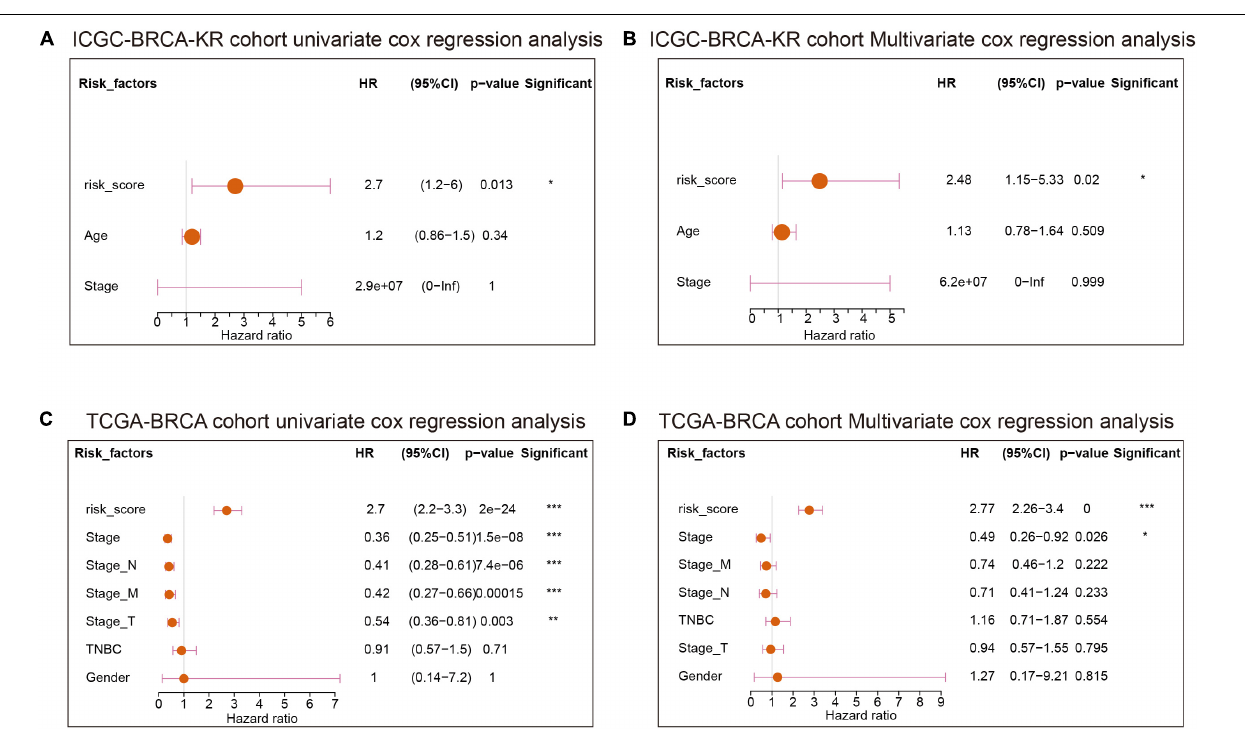
FIGURE 6 | The Cox regression of clinical characteristics and risk score of GVRM. (A,B) The univariate Cox regression analysis and multivariate Cox regression of clinical characteristics and risk score of GVRM in the ICGC-BCRA-KR cohort, respectively. (C,D) The univariate Cox regression analysis and multivariate Cox regression of clinical characteristics and risk score of GVRM in TCGA-BRCA cohort, respectively. * p < 0.05, ** p < 0.01 and *** p <